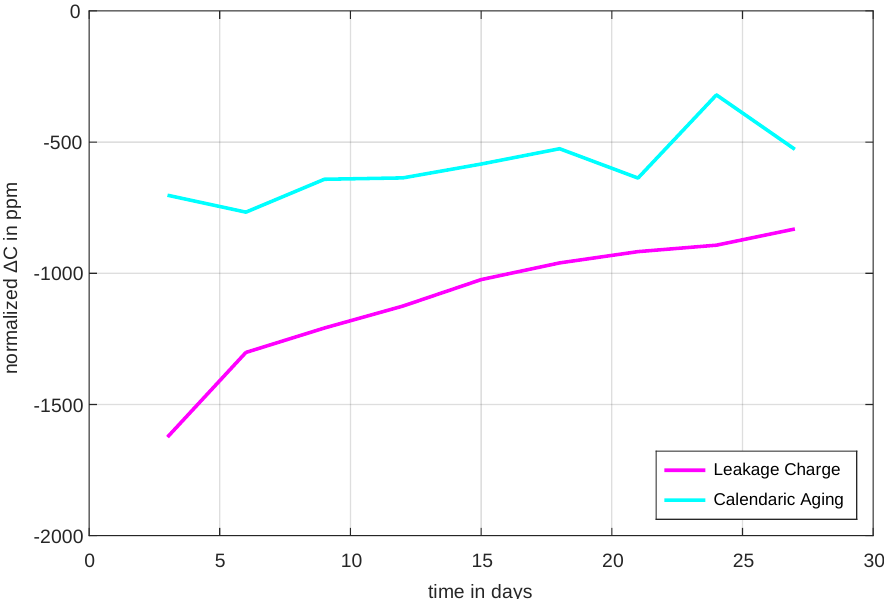
Figure 17. Calendrical aging and leakage current charge losses for the high-SoC-scheme plotted over the measurement time. It can be seen that these rates also change significantly over